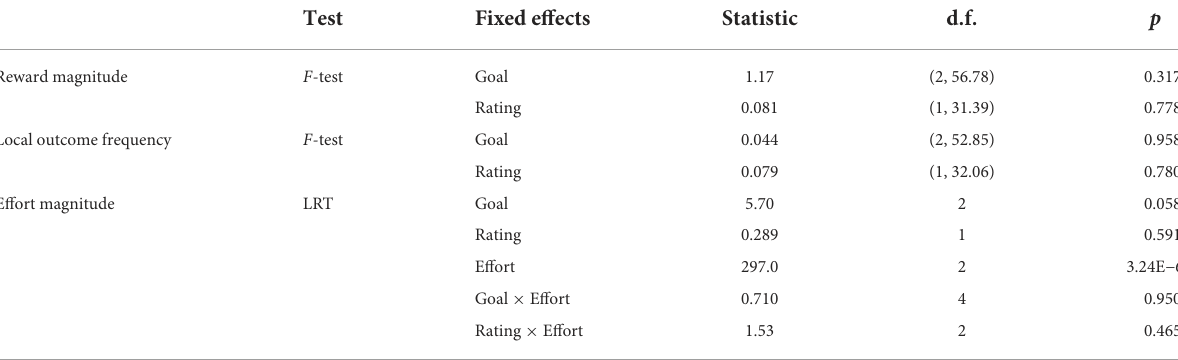
TABLE 2 Summary of statistical analyses of behavioral factors potentially influencing event-related